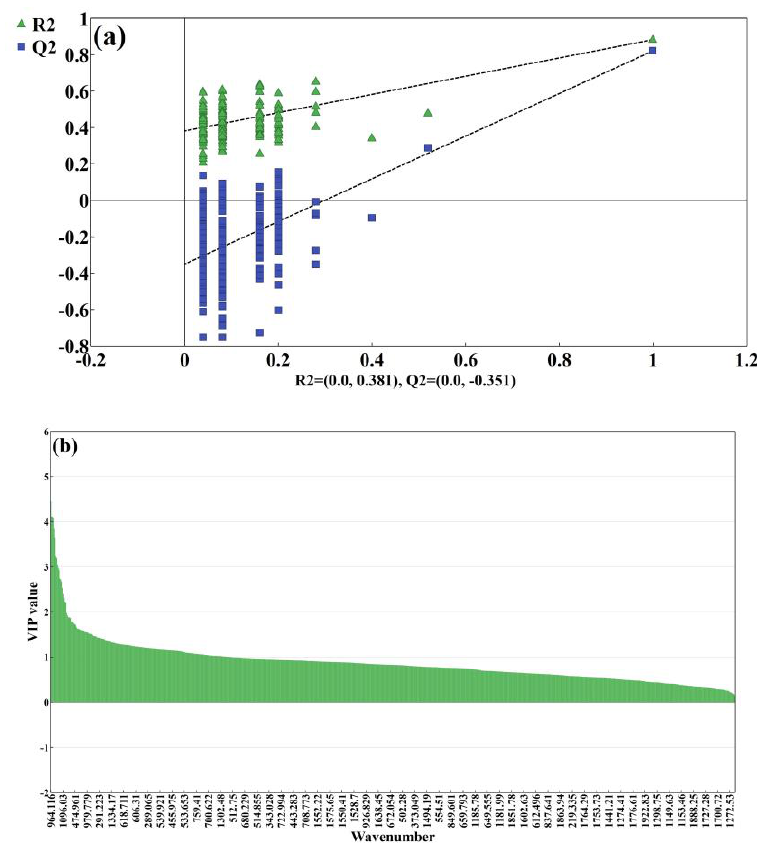
Figure 5. ( a ) Permutation test analysis of the OPLS-DA model, the green dots represent R 2 and the blue dots represent Q 2 . ( b ) Valuable importance for the projection (VIP) plot of classification.